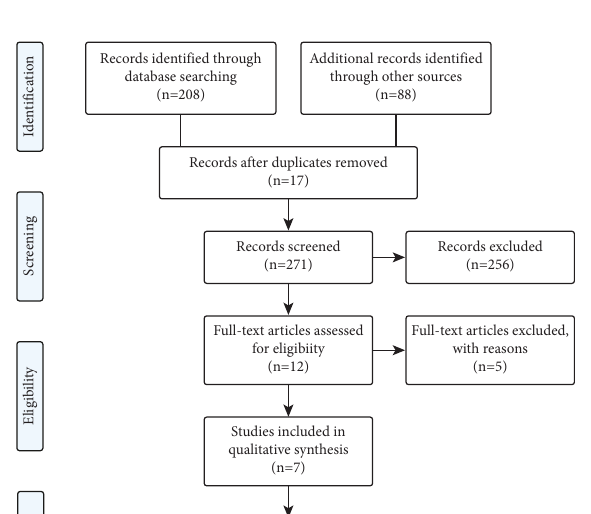
Figure 1: Funnel plot.